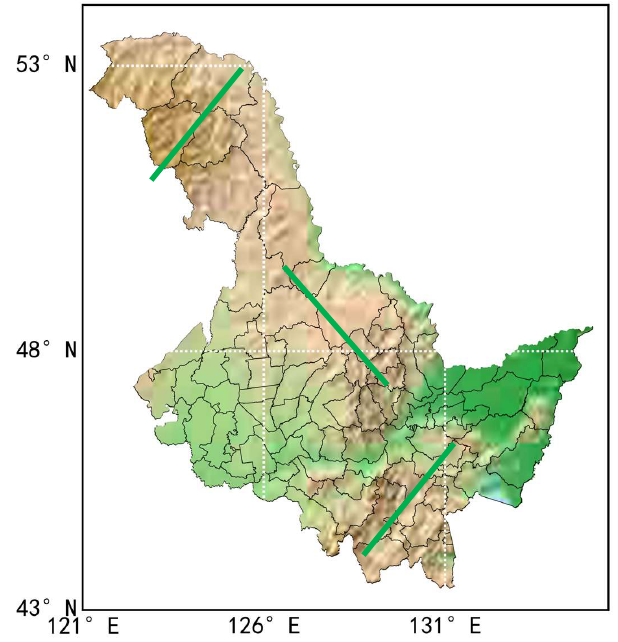
Figure 1. Topographic map of Heilongjiang Province (the thick green lines from west to east represent the Greater Khingan Mountains, the Lesser Khingan Mountains and the Changbai Mountains, respectively).